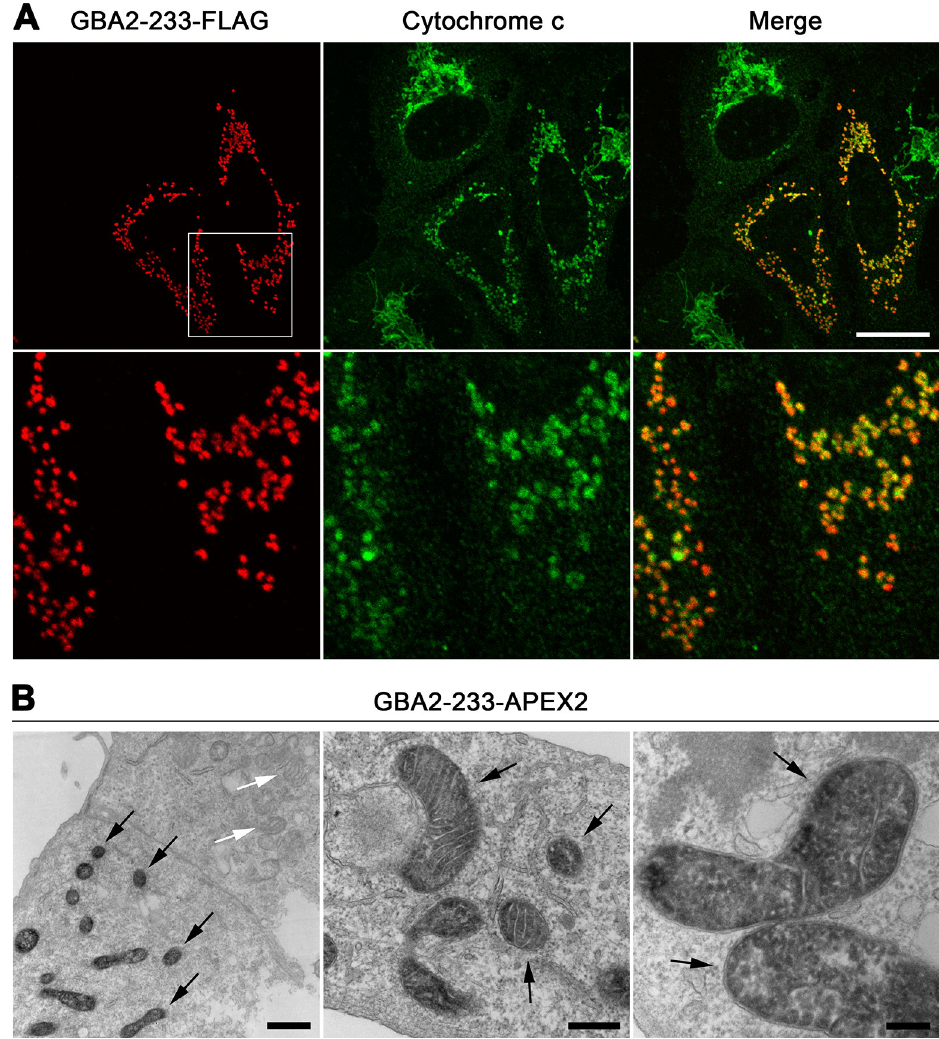
immunostained with anti-FLAG (red) and anti-cytochrome c antibodies (green). A section (white square) of the images in the upper panels is enlarged in the lower panels. Scale bar, 20 μ m. (B) Localization of APEX2-tagged GBA2- 233 by electron microscopy. Black arrows point to APEX2-stained mitochondria; white arrows point to non- APEX2-stained mitochondria. Scale bars: left panel, 1000 nm; middle panel, 400 nm; right panel, 200